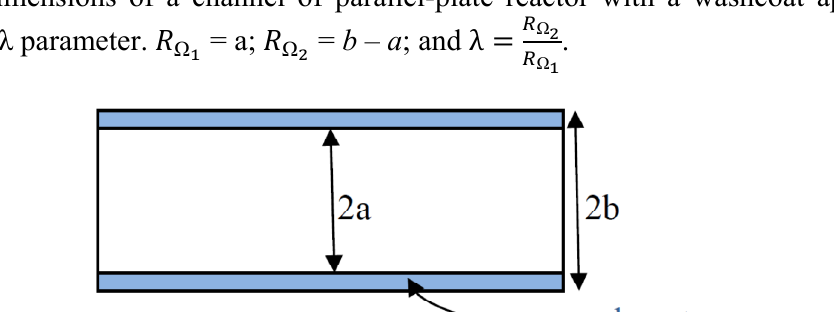
= a; (cid:1844) = b – a ; and λ = Ω (cid:3117) Ω (cid:3118)